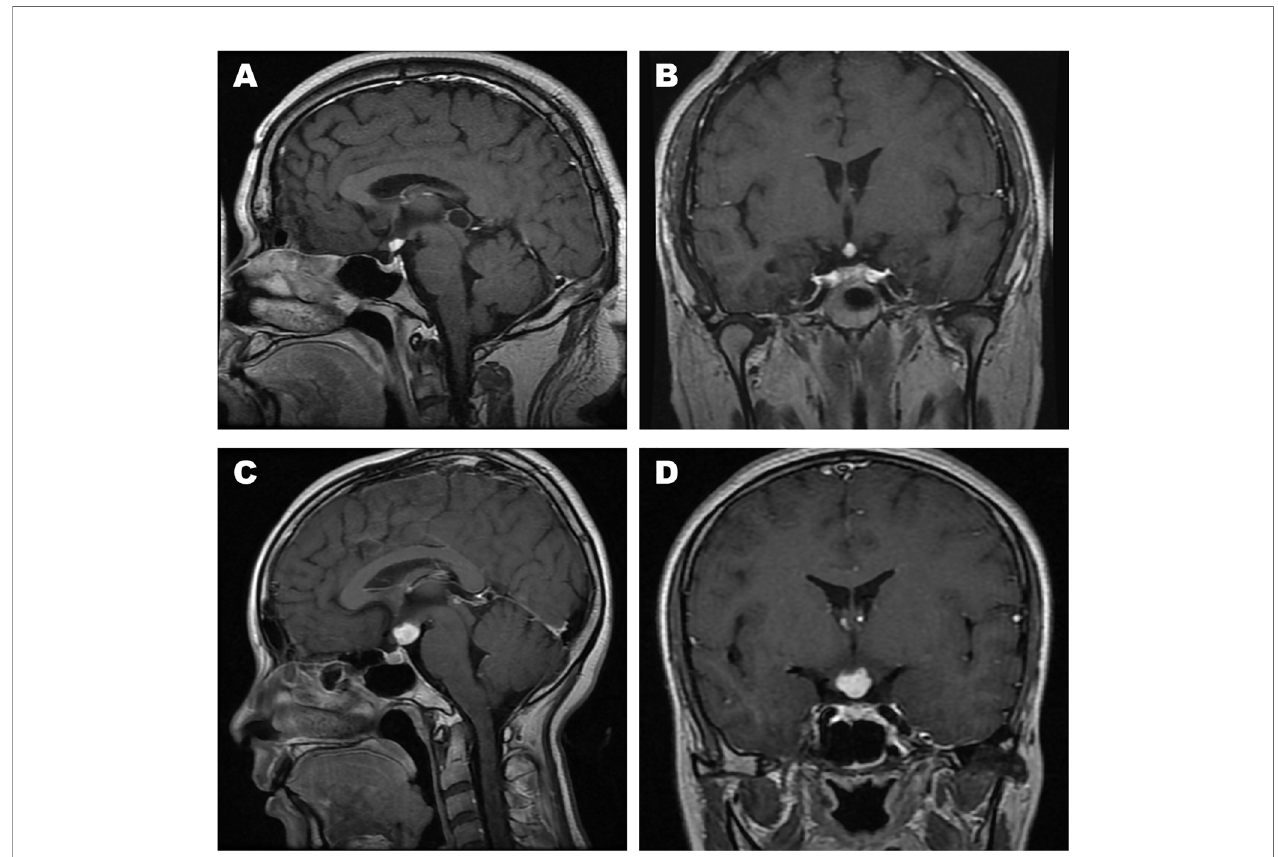
FIGURE 2 | The T1-weighted postcontrast MR images of two typical cases. (A) Sagittal view of patient No. 7; (B) Coronal view of patient No. 7; (C) Sagittal view of patient No. 10; (D) Coronal view of patient No.